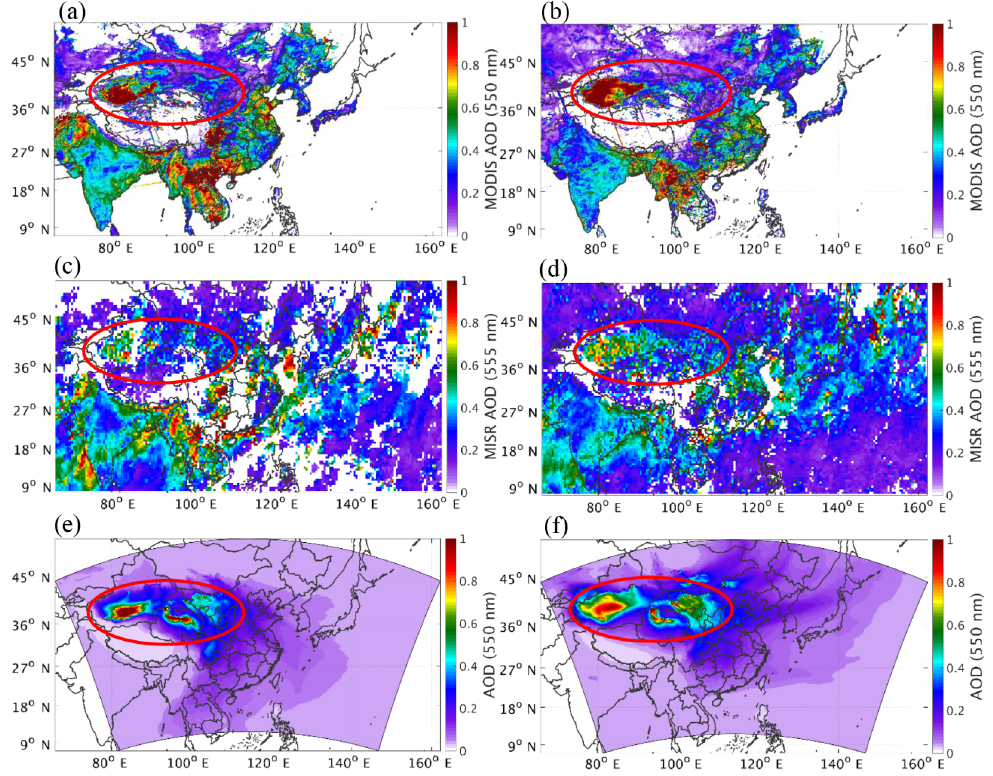
Figure 5. Spatial distributions of monthly mean AOD from MODIS observations (a, b) , MISR observations (c, d) , and simulation results (e, f) for March (left column) and April (right column) of